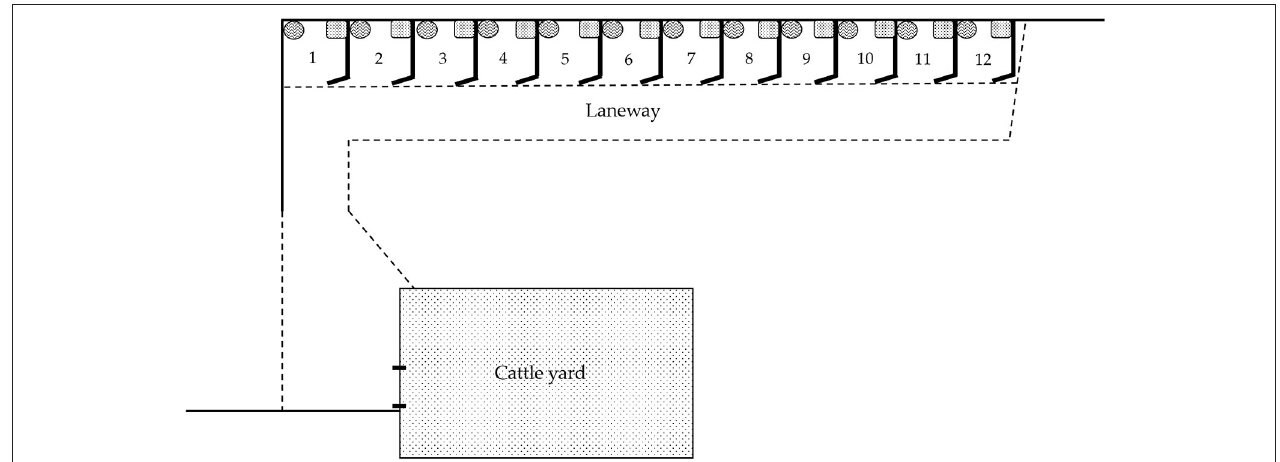
FIGURE 3 | Diagrammatic representation (not to scale) of the feed pens used for feeding out rations. The feed pens 5 × 5m were used to individually feed out rations. Pens 1–6 were assigned to the restricted cows. Pens 7–12 were assigned to the above maintenance cows. Pens consisted of individual water (60L, 400 × 400 × 370mm) and feed buckets of lucerne cubes (60L, 400 × 400 × 370mm). Shade was also provided over each pen (not shown in this figure). During feeding, the cows were individually moved from the cattle yards along the laneway and into their assigned feed pen (1–12) and closed in with the temporary fence. This was repeated until all cows were secured into their pens and eating. After feeding the temporary fence was removed, and all cows were walked back along the laneway into the cattle yards.